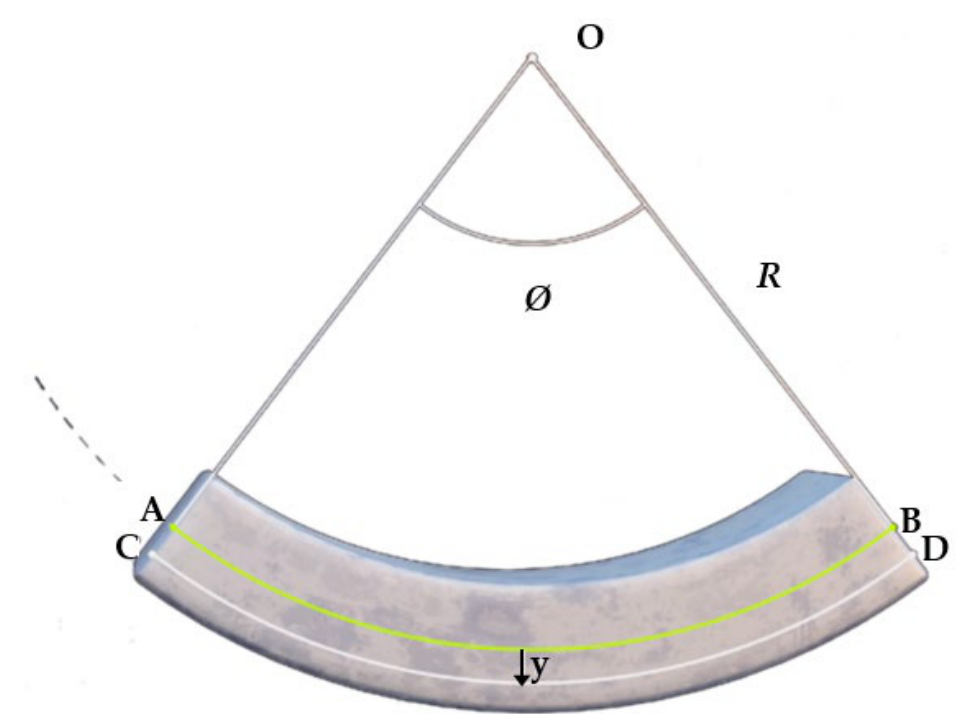
Figure 1. Beam loaded by a pair of moments to derive the double integration method.